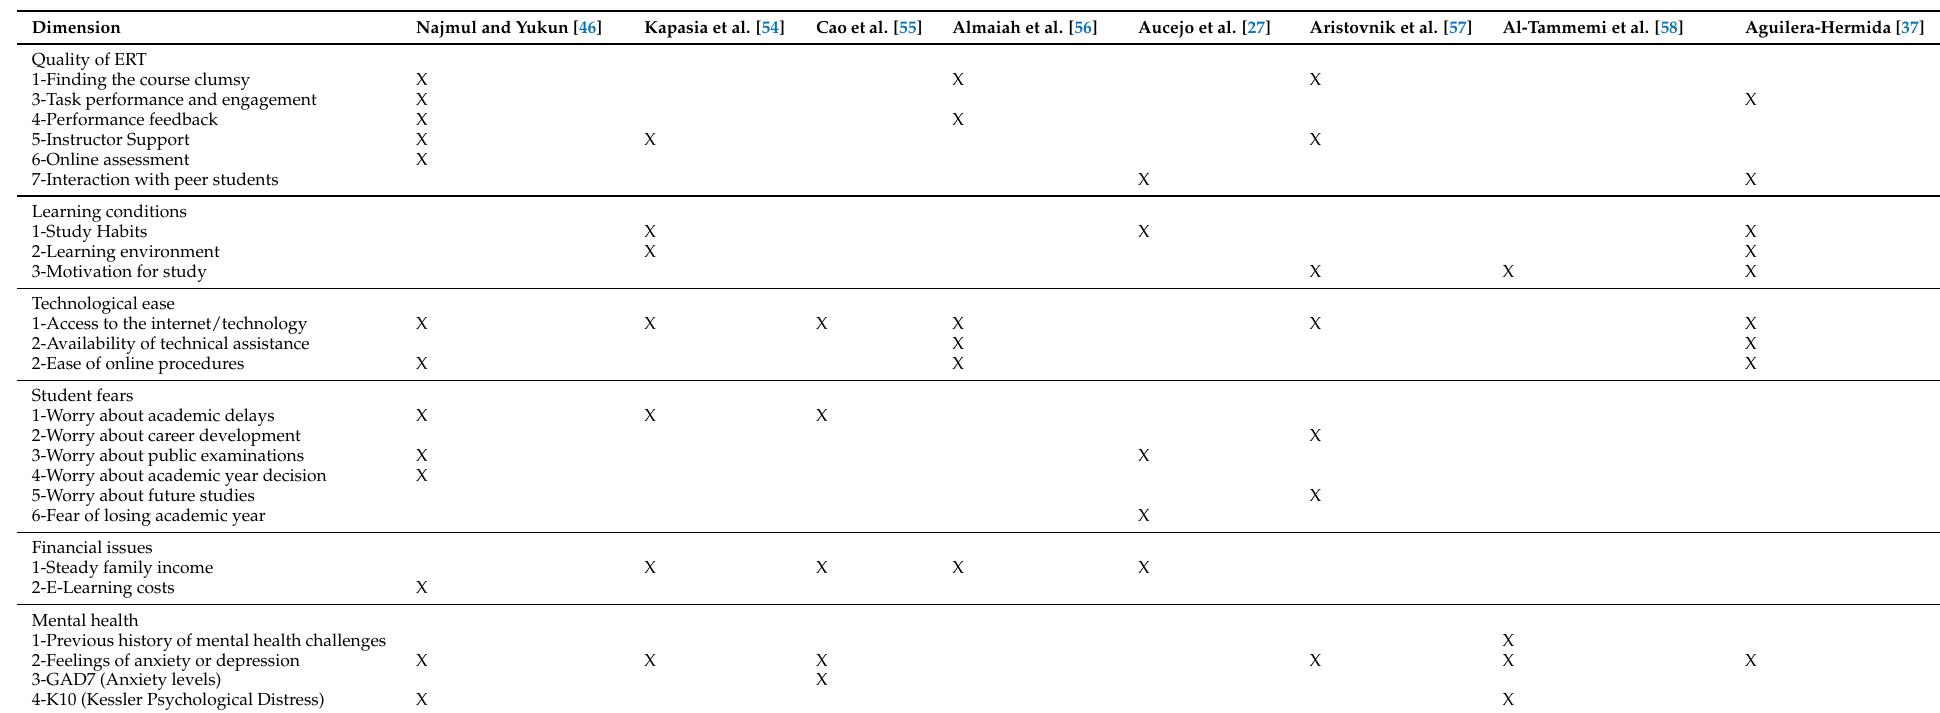
Table 1. Dimensions of assessing the impact of